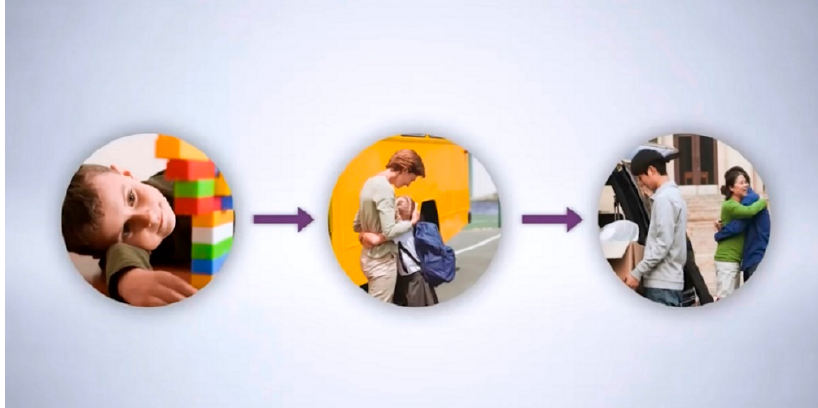
Figure 1. Infographic condition screenshot.